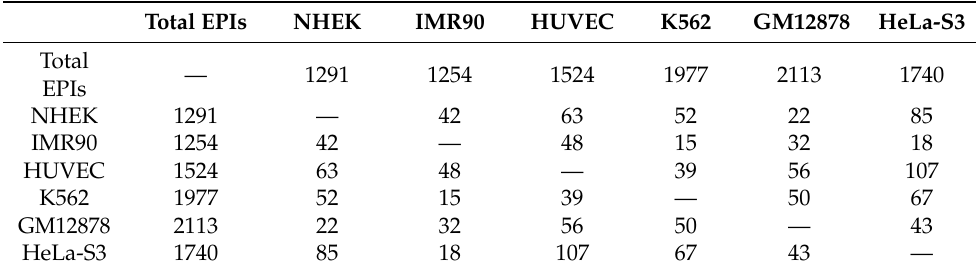
Table 7. The analyses of EPIs overlap ratio for different cell lines